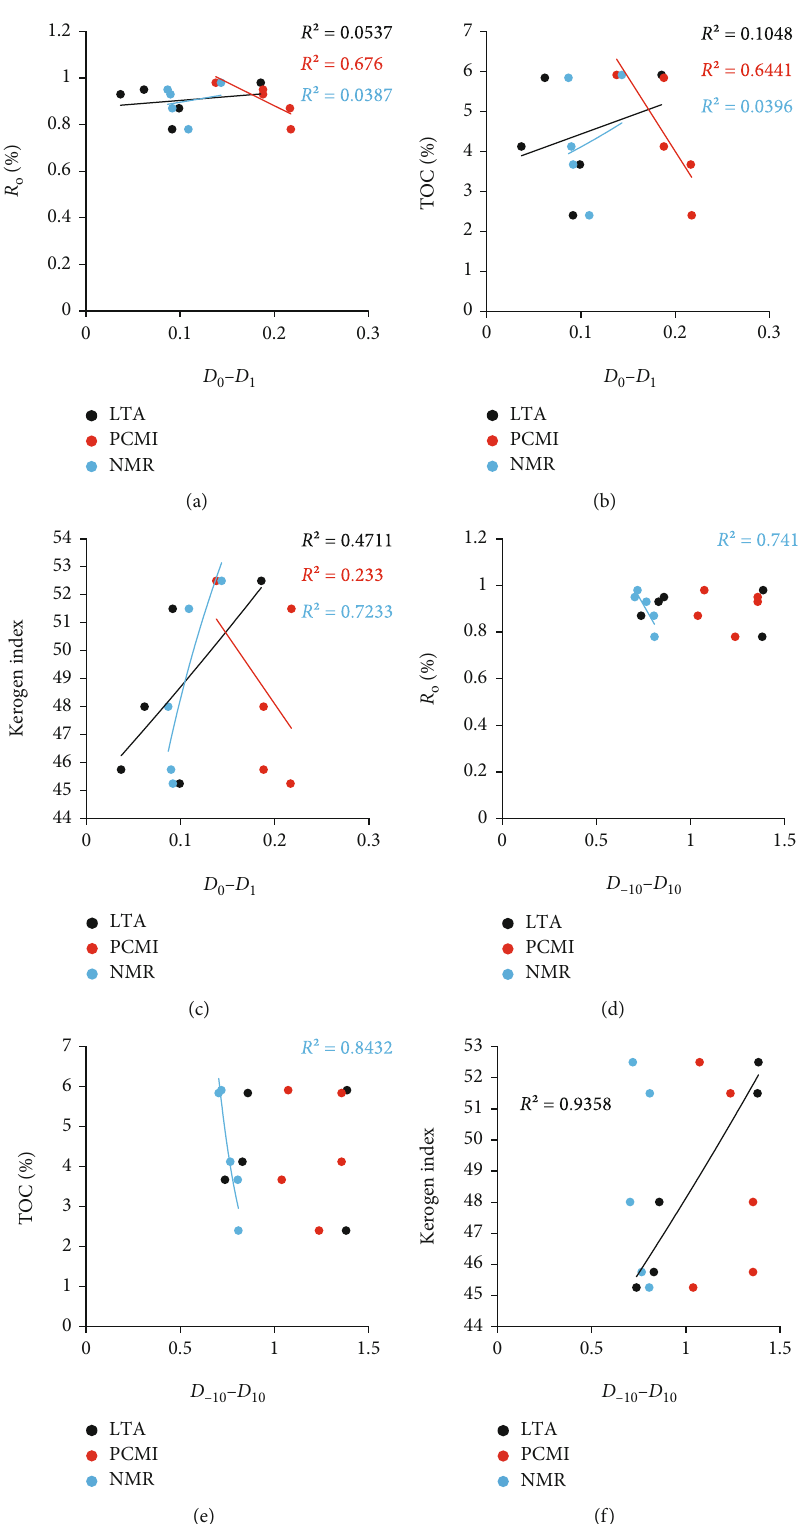
- D vs. (a) average R 0 1